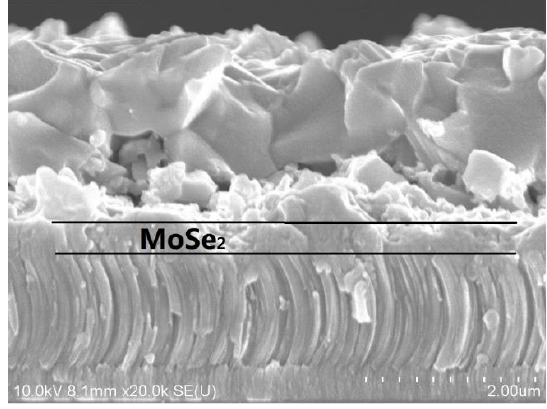
Figure 6. The magnification SEM image of Figure 5c.